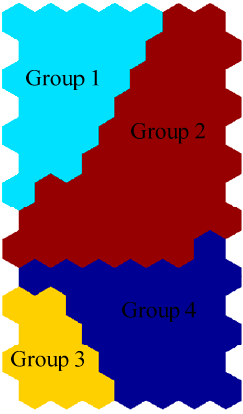
Figure 4. Davies-Bouldin clustering index of the K-means clustering algorithm.